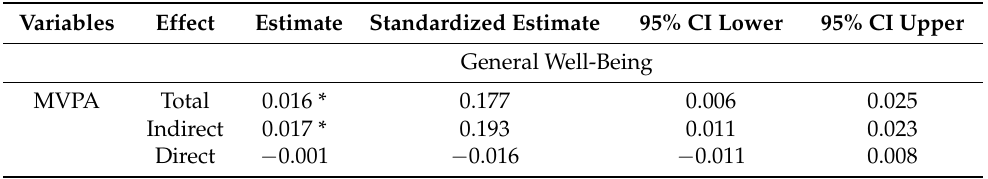
Table 2. Mediation indices for general well-being with recovery experiences as mediator.